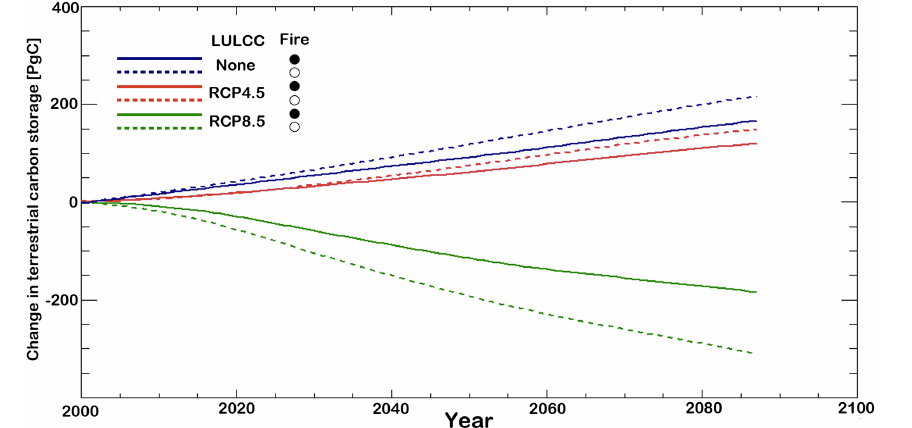
Figure 4. Time series of the projected change in global terrestrial carbon storage for CLM simulations with RCP4.5, with RCP8.5, and without LULCC (red, green, and blue, respectively), and with and without fires (solid and dashed, respectively), relative to the year 2000. The time series is smoothed with a 25-year running average.